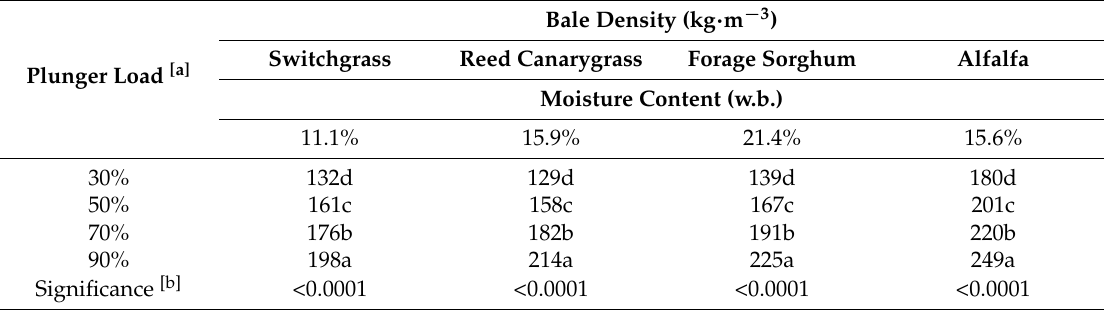
Reed Canarygrass Forage Sorghum Alfalfa